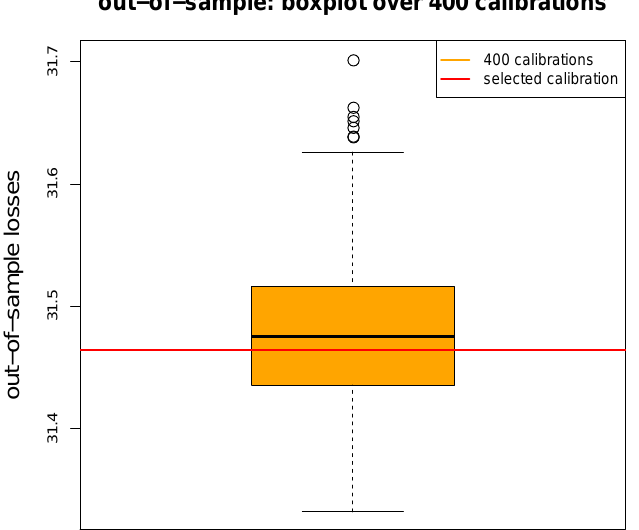
Figure 2. In-sample losses ( top ) and out-of-sample losses ( bottom ) over 400 different runs of the gradient descent algorithm with different seeds j = 1, . . . ,400, the blue and red lines show the network regression model on line (d) of Table 2 with seed j =